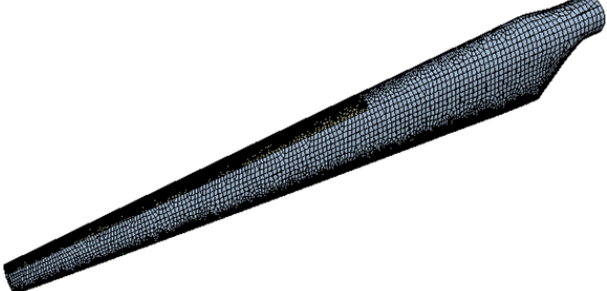
Figure 10. Meshed geometry (computational domain) used for the FEA of the full-scale wind turbine blade with LEP bonded to the leading edge (as shown in